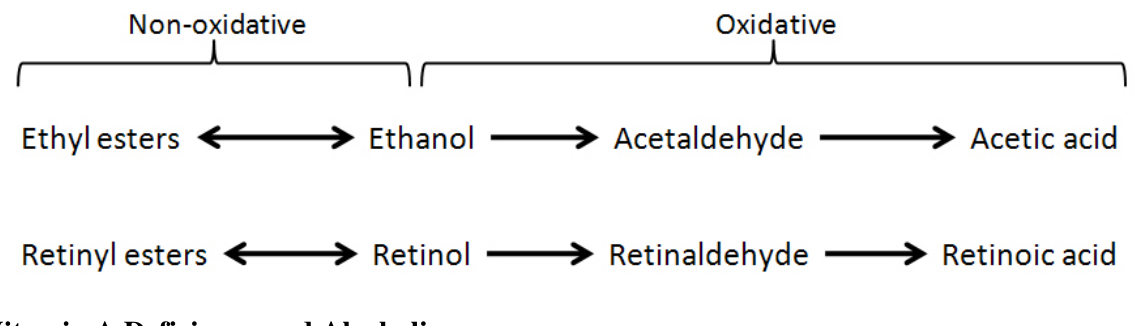
Figure 1. Biochemical parallels in the metabolism of ethanol and retinol. The conversion of ethanol to acetaldehyde is mediated by different processes within the cell; this reaction can be catalyzed by alcohol dehydrogenase, CYP2E1, and to a lesser extent, catalase. The conversion of the primary alcohol, retinol, to retinaldehyde can also be catalyzed by alcohol dehydrogenase subtypes, as well as specific retinol dehydrogenases. In both cases, the subsequent oxidation of the aldehyde to a carboxylic acid is mediated by aldehyde dehydrogenases. Within the liver, the synthesis of retinyl ester is catalyzed by lecithin: retinol acyltransferase (LRAT); the molecular identity of enzymes which synthesize fatty acid ethyl esters are currently